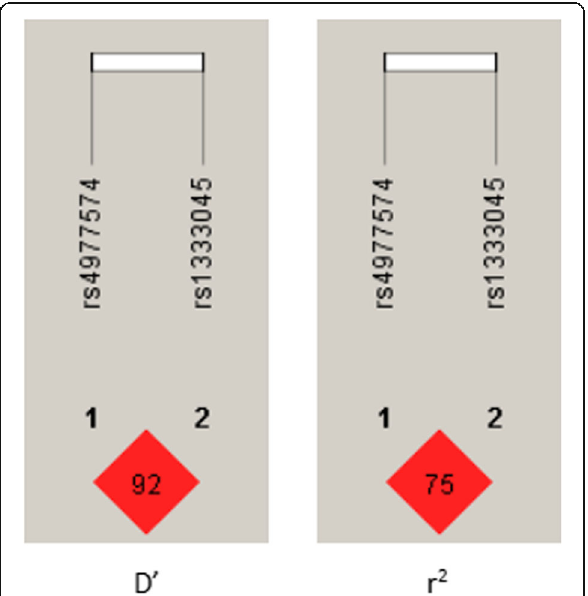
Fig. 2 Haplotype analysis between the two groups of